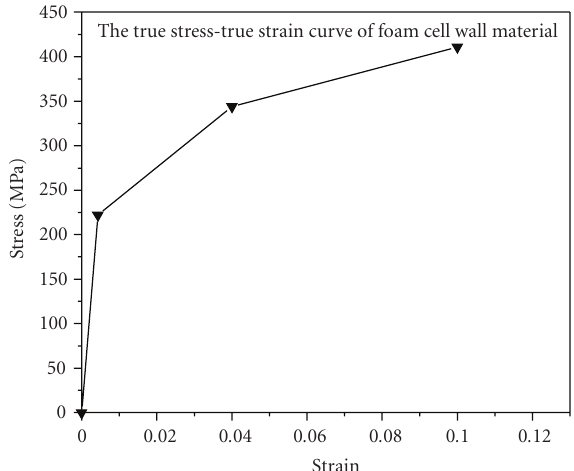
Figure 2: The stress-strain curve of 322 and Foam Tech foams obtained from